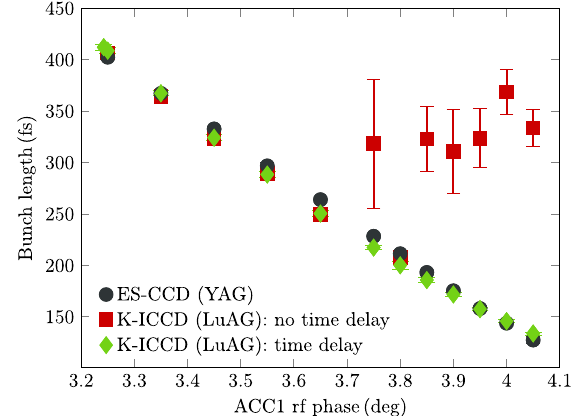
FIG. 9. Electron bunch length measurements for varying ACC1 rf phase at ES-CCD and K-ICCD using different readout configurations. According to Sec. III, the measurements in the magnetic energy spectrometer (‘‘ES-CCD (YAG)’’) are intended to provide an absolute reference measurement.